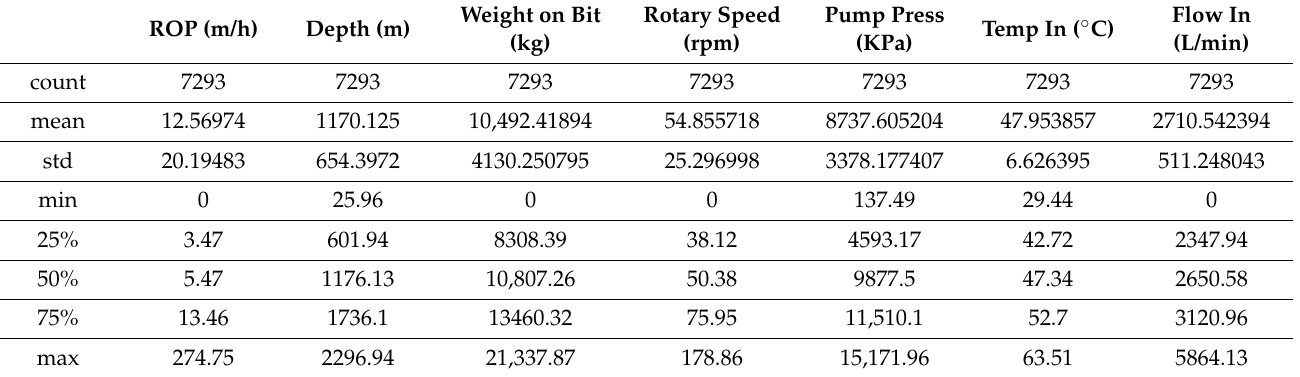
Table 3. Drilling dataset after pre-processing.